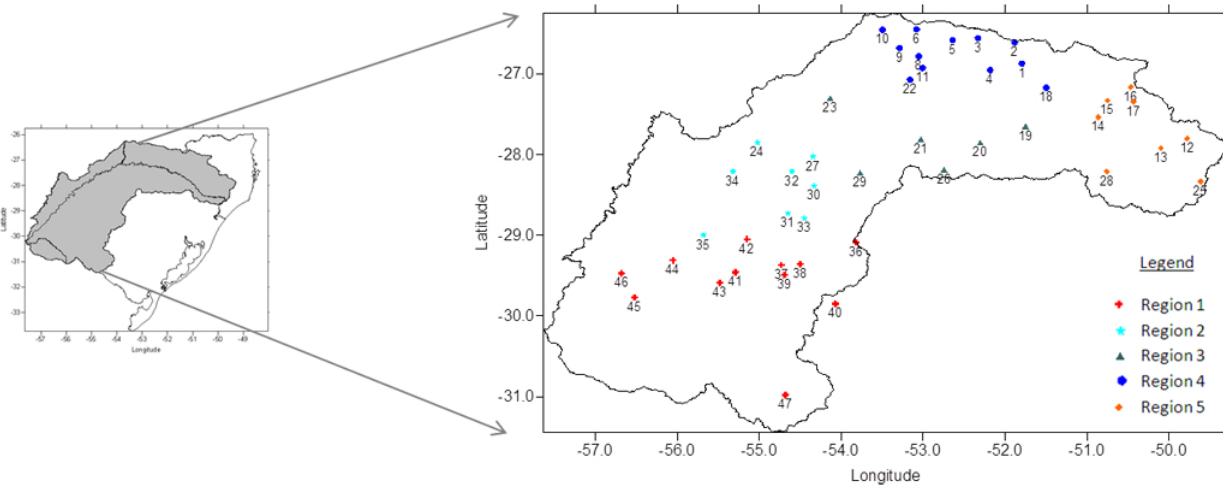
Fig. 1. Location of climatic stations of the ANA (National Water Agency) separated by homogeneous regions according to rainfall data.